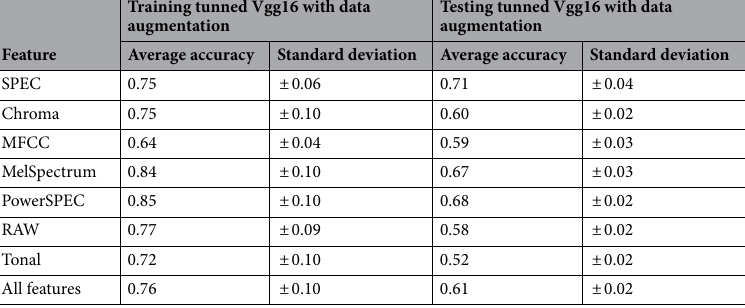
Table 7. Average classification performance for the training and testing of the tuned Vgg16 network with data augmentation over 100 training